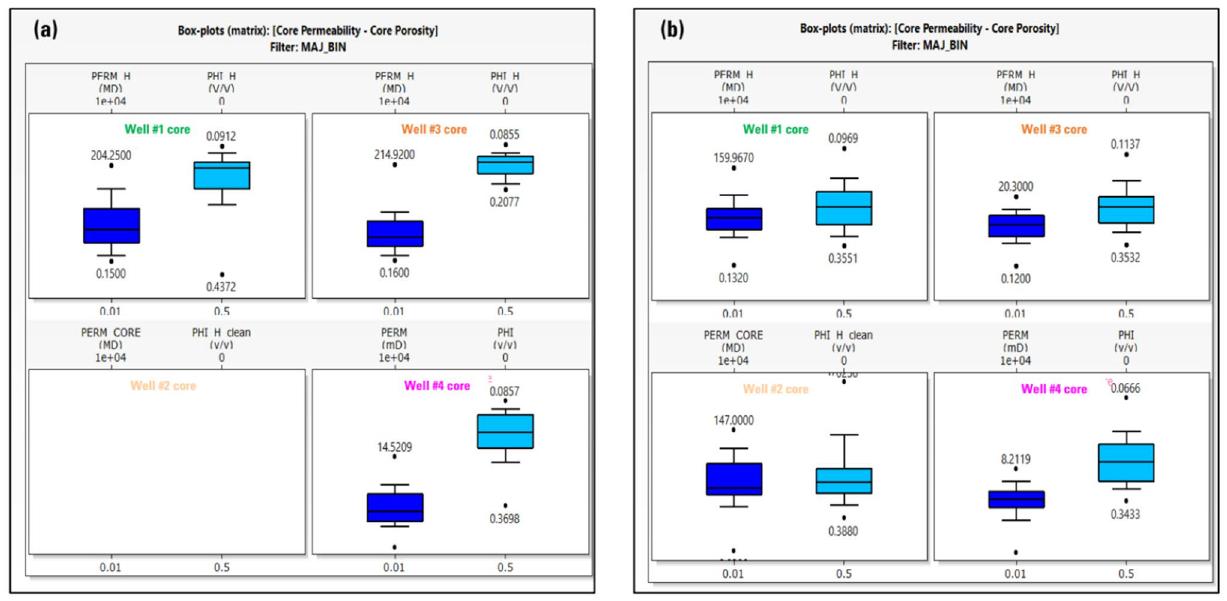
Fig. 9 Porosity–Permeability distribution box plot for cores data in a Mauddud and b Shuaiba